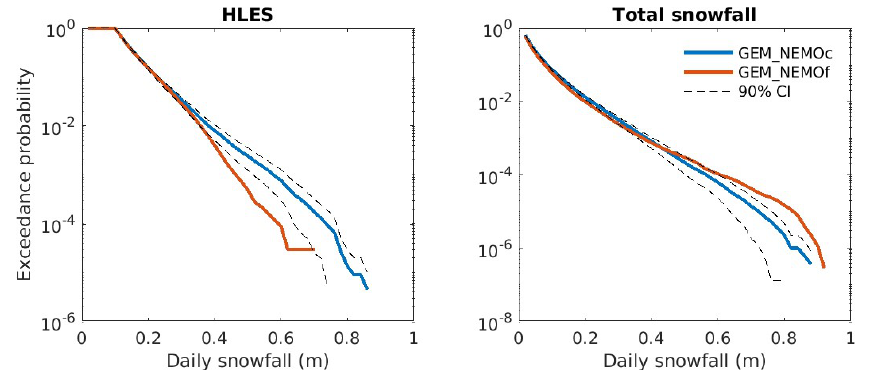
Figure 7. Intensity-frequency diagrams for HLES ( left ) and total snowfall ( right ) over the region within 200 km of the Great Lakes shorelines, for the 1989–2010 period (GEM_NEMOc, blue lines) and the 2079–2100 period (GEM_NEMOf, red lines). The 90% confidence interval for the 1989–2010 period is shown with black dashed lines.